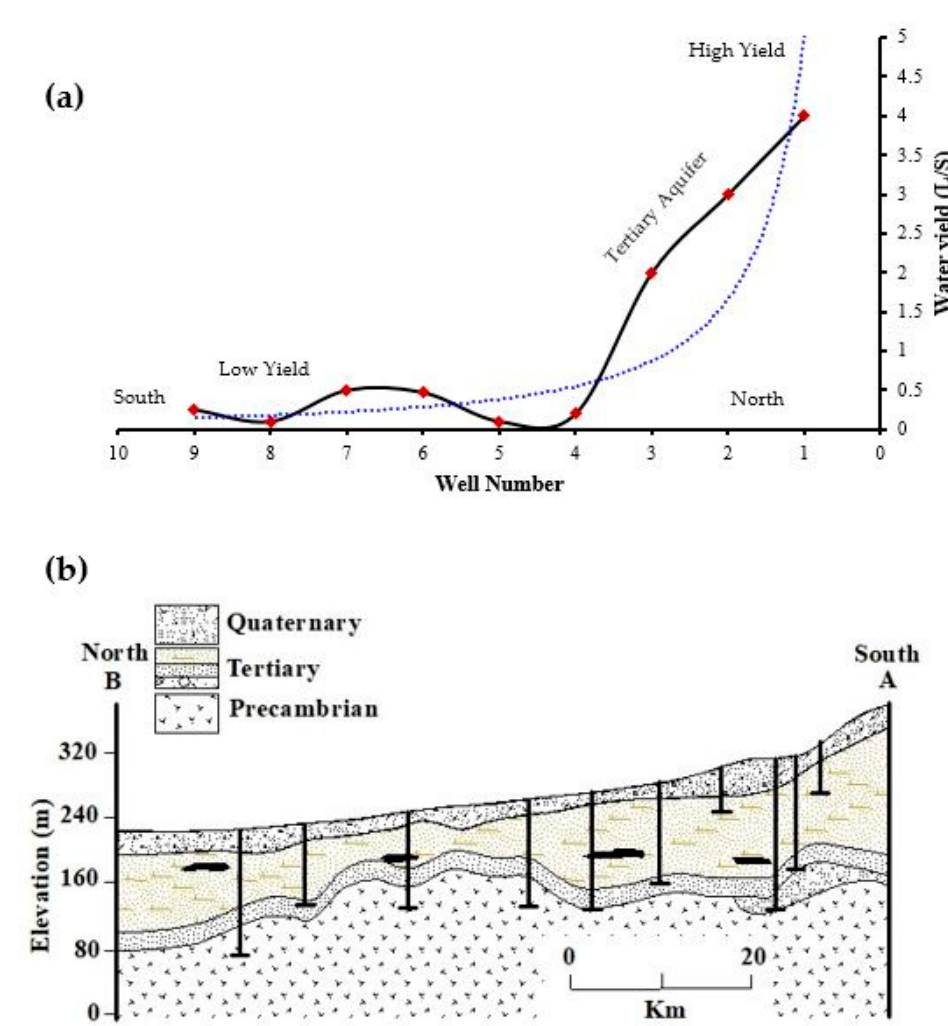
Figure 13. ( a ) Groundwater yield along the hydrogeological cross-section. ( b ) Hydrogeological cross-section from the southern areas to northern areas.